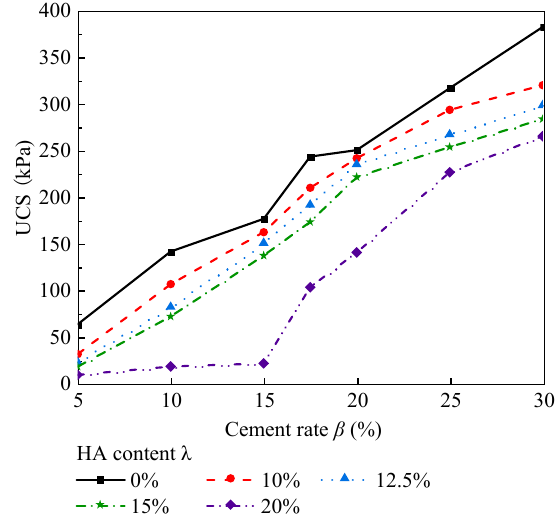
Figure 9. Relation curve between UCS and cement ratio.